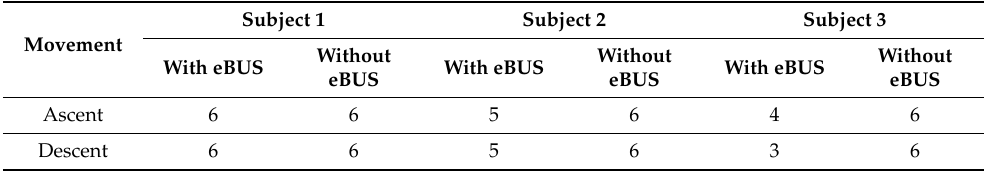
Table 3. Analyzable data per subject (S1, S2, S3), movement (ascent, descent), and setting (with/without